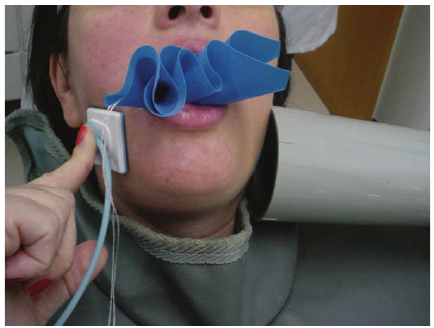
Figure4:Extraoraltechniqueusedforthemandibularmolarduring root canal therapy.